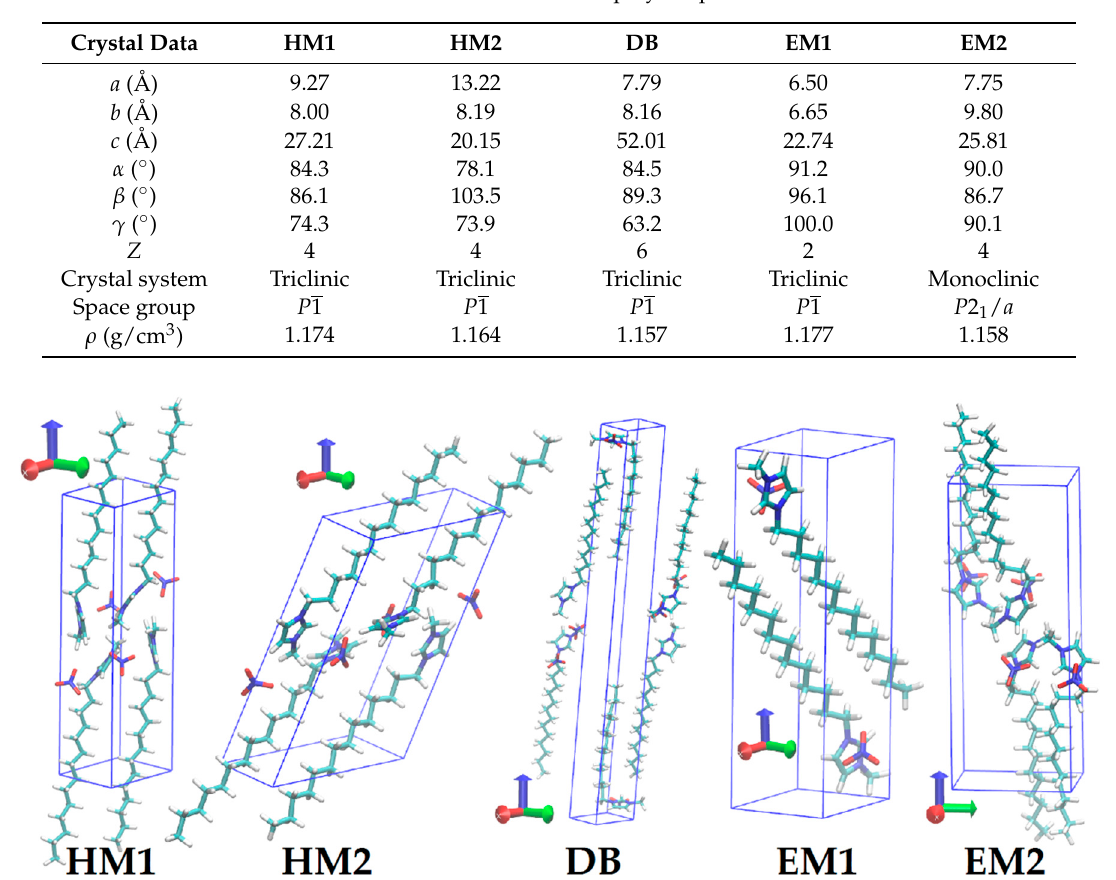
Figure 2. Unit cells of crystal structures at T = 200 K. The lattice vector a is along the x axis (red). Table 1. Lattice constants of the five polymorphs at T = 200 K.